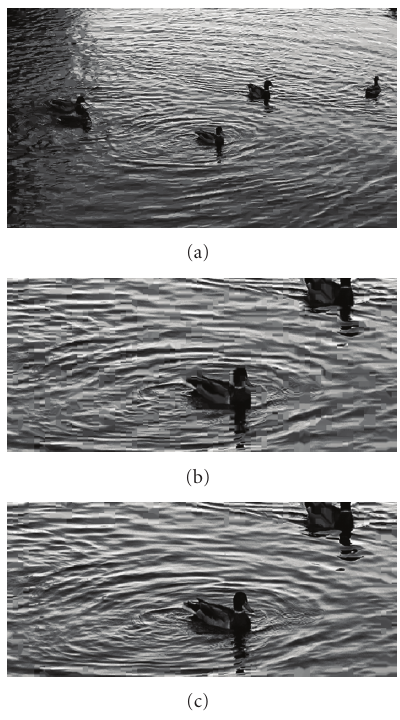
Figure 9: Ducks take o ff sequence: entire frame and ROI disabled (a); detail without (b), and with ROI (c).